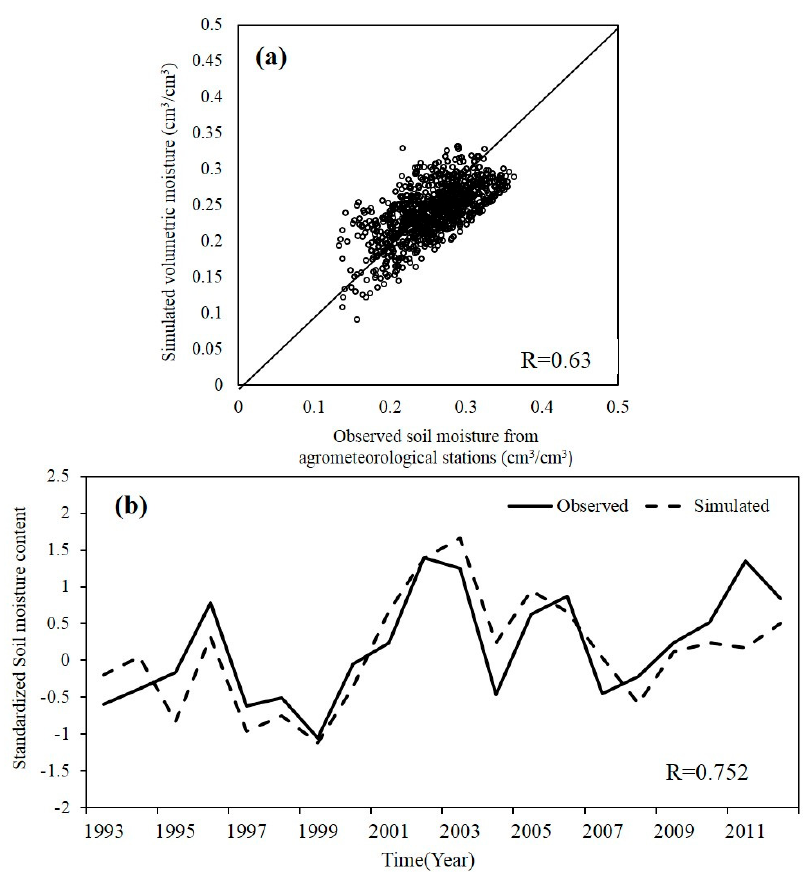
Figure 3. ( a ) Comparison of SWAT-simulated and observed monthly soil moisture of top 50-cm during 1993–2012; ( b ) interannual variations of standardized SWAT-simulated and observed average soil moisture of the WRB during 1993–2012.